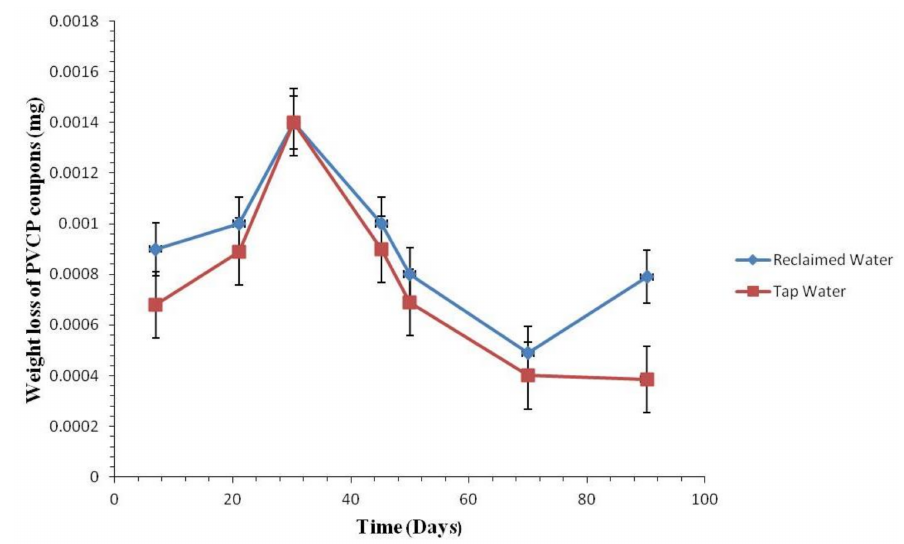
Figure 15. Weight loss of polyvinyl chloride pipe coupons with RW and TW over time with standard error bars.